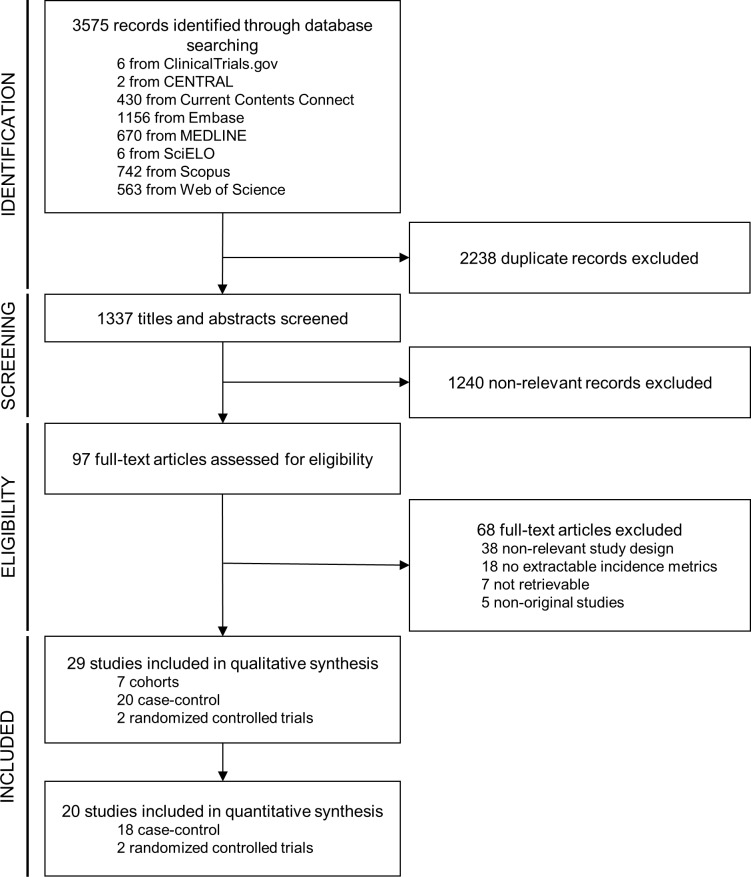
PRISMA flow diagram for study selection process.